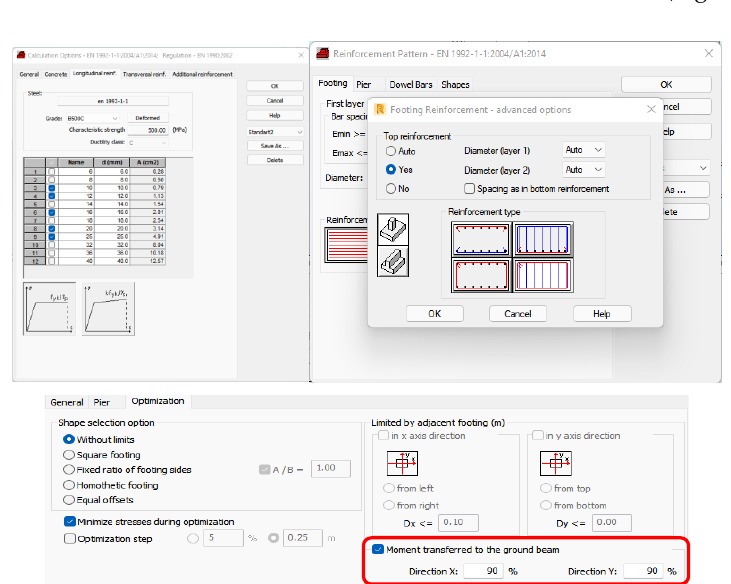
Figure 11. Detailing selected options for the reinforcement of foundations.